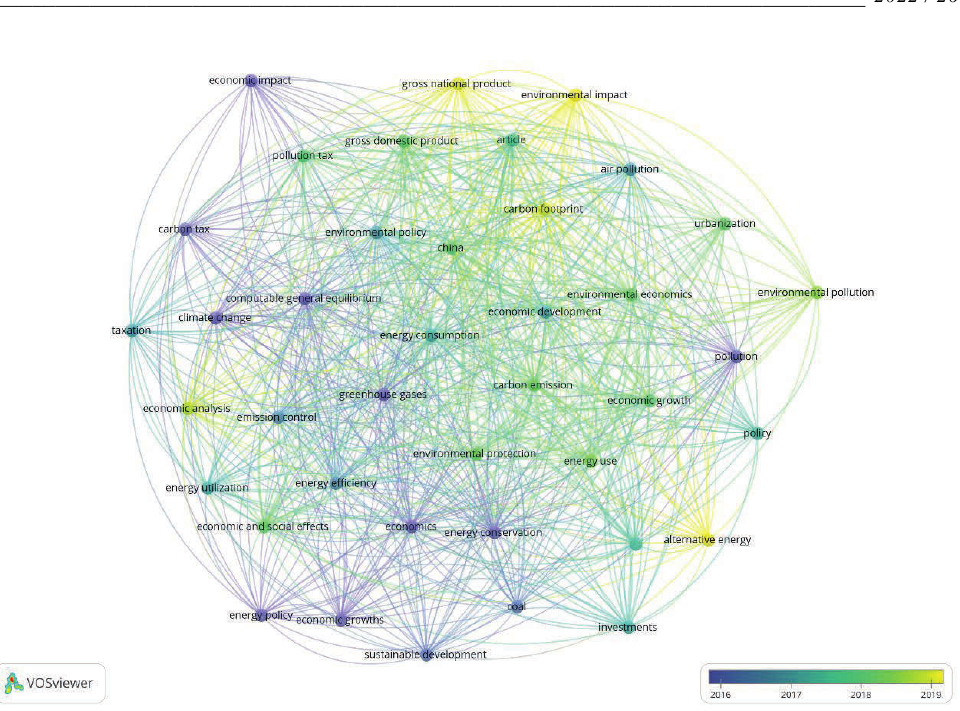
Fig. 5. Keyword co-occurrence for 1st query with a threshold of at least 10